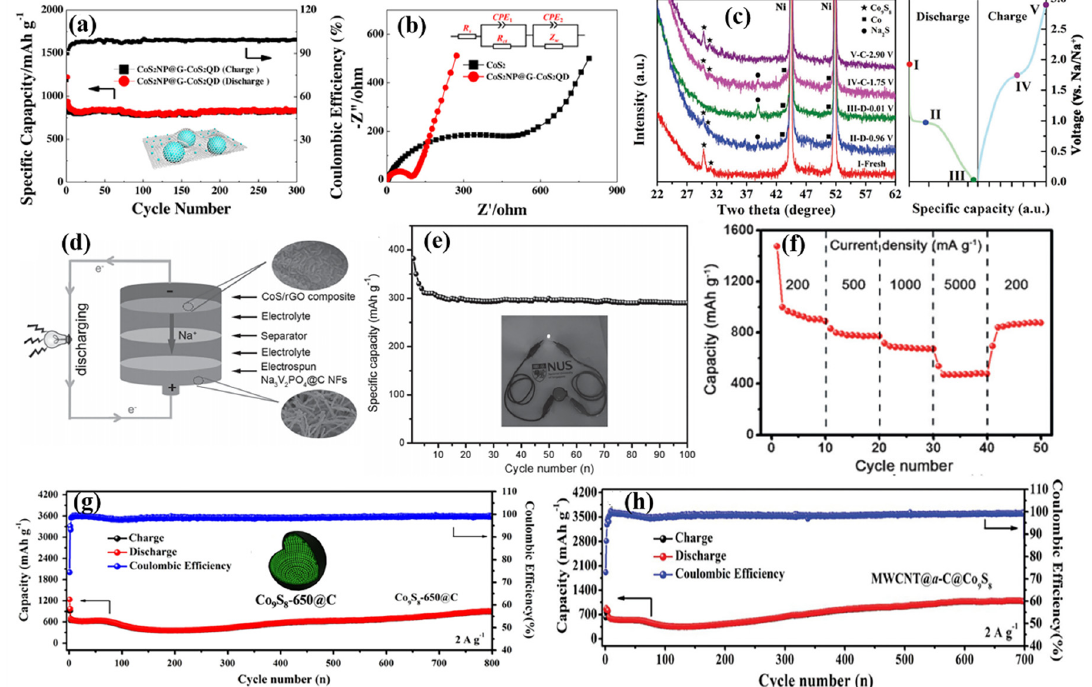
Figure 11. Electrochemical performances of cobalt-based anode materials. ( a ) Cycle performance of CoS 2 -quantum-dots-anchored graphene nanosheets (CoS 2 NP@G-CoS 2 QD) at 1 A g − 1 . ( b ) Nyquist plots of CoS 2 and CoS 2 NP@G-CoS 2 QD electrodes after 300 cycles [187]. ( c ) Ex-situ XRD of the cobalt sulfides quantum dots@mesoporous hollow carbon polyhedral@reduced graphene oxide (Co 9 S 8 QD@HCP)@rGO electrode tested at di ff erent voltage states [172]. ( d ) Schematic illustration and ( e ) cycle performance of CoS@rGO // Na 3 VPO 4 (NVP)@C sodium ion full cell [173]. ( f ) Rate performance of CoS 2 bubble-like hollow prisms [174]. ( g ) Cycle performance of Co 9 S 8 -650@C in LIBs [175]. ( h )